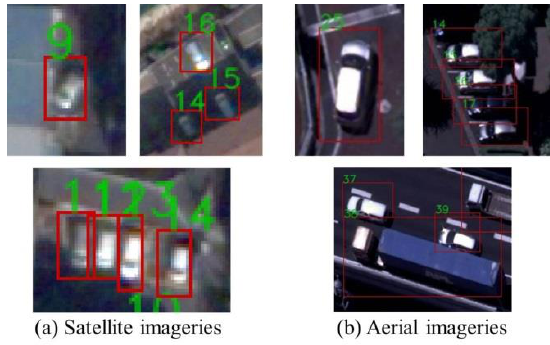
Figure 3. Examples of vehicle bounding